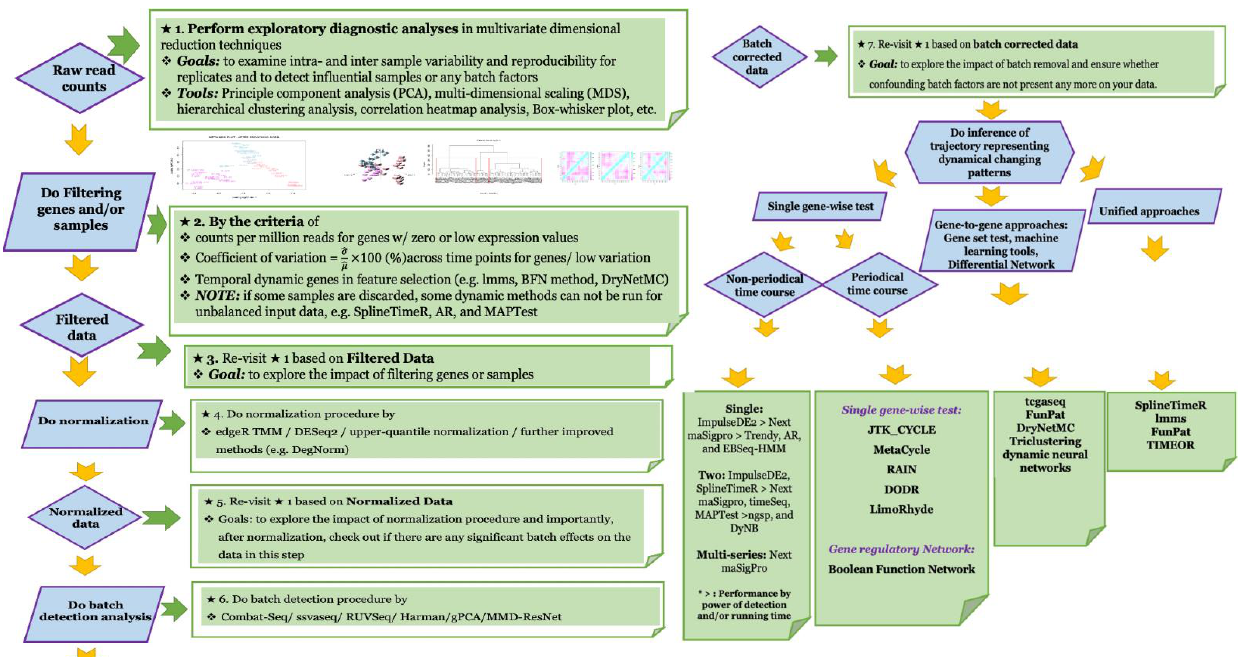
Figure 1. It depicts the schematic illustration of complete analytical pipeline for the dynamic time course data.